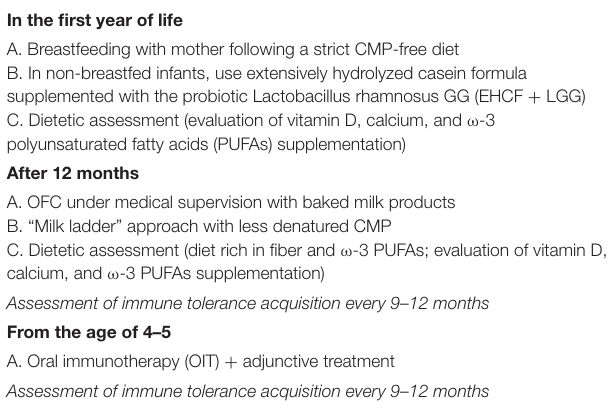
TABLE 4 | The key messages of the immunonutrition approach in CMA